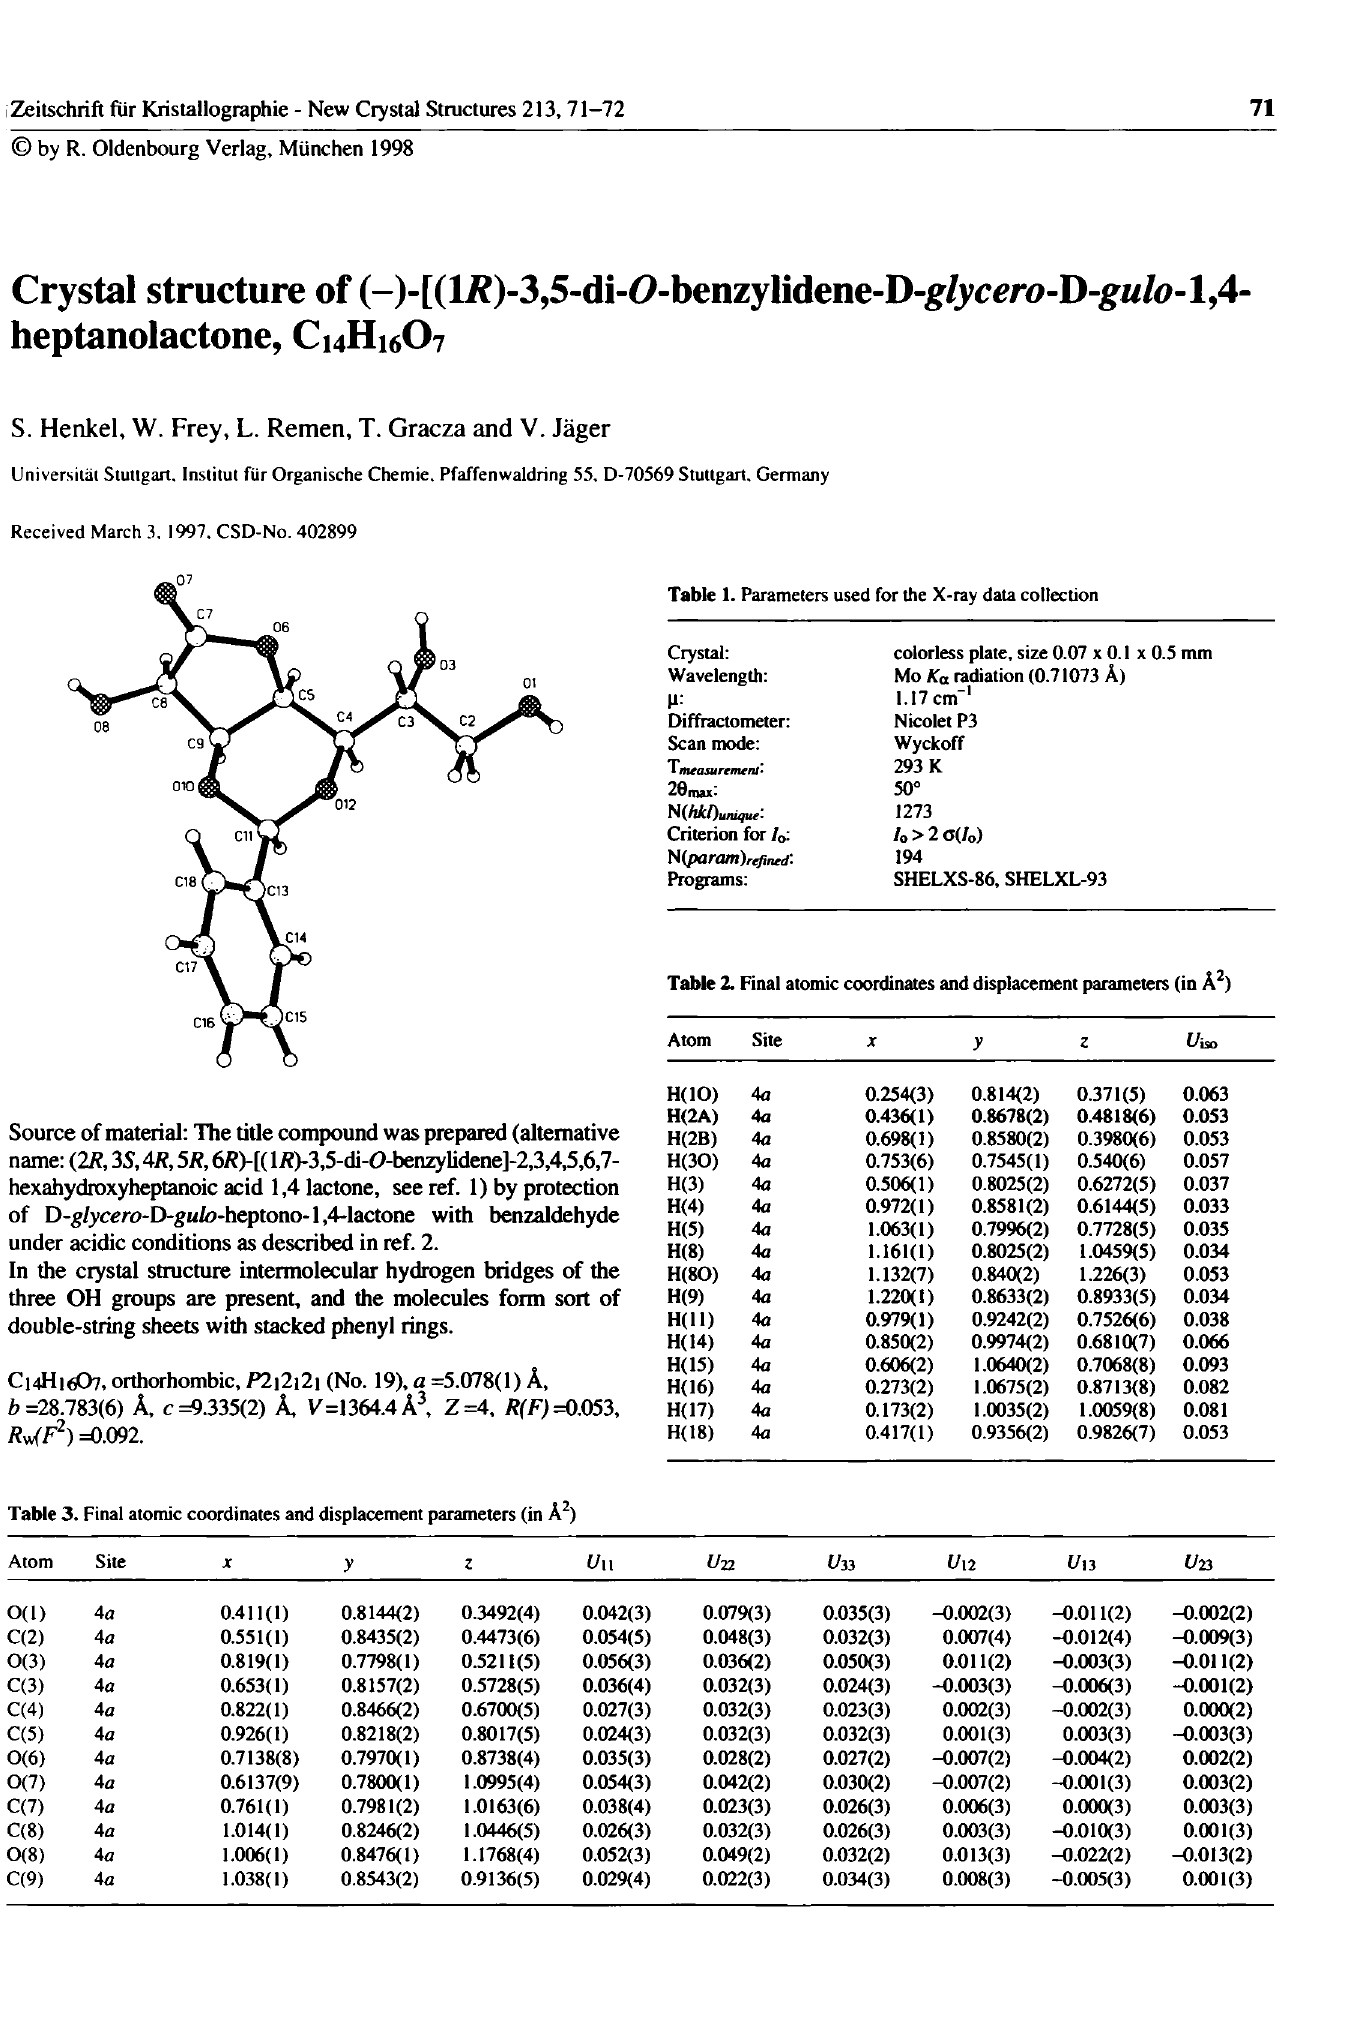
Table 1. Parameters used for the X-ray data collection